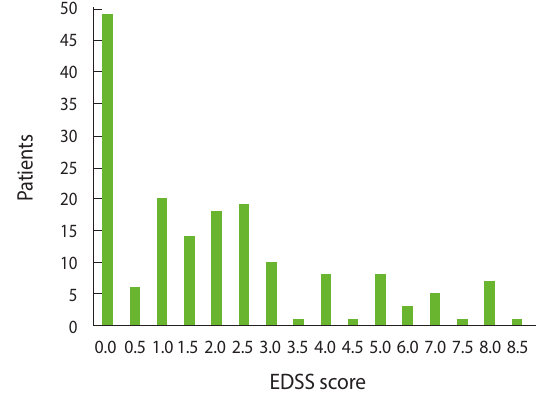
Figure 1. Distribution of patients by Expanded Disability Status Scale